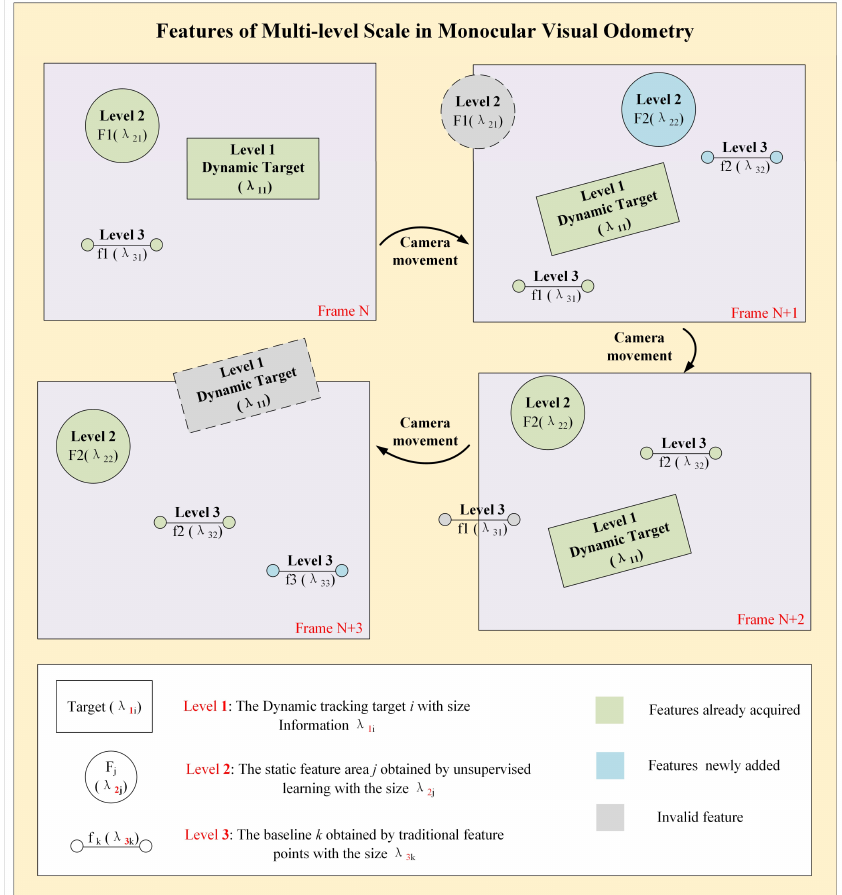
Figure 4. Schematic diagram of the relationship between multi-level feature baselines and camera motion.